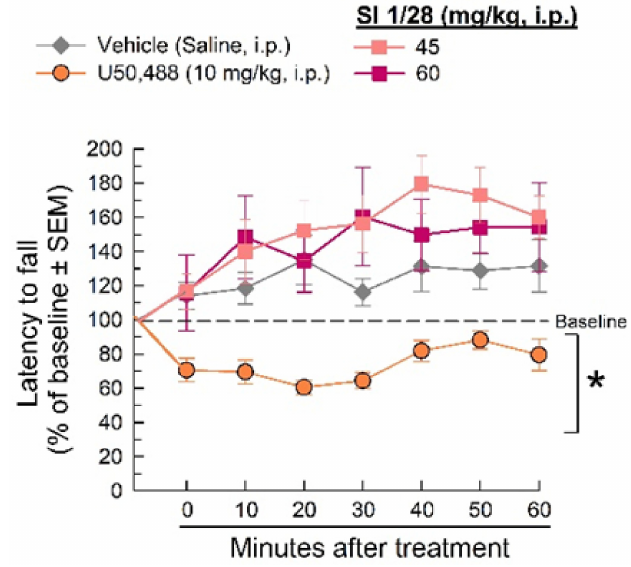
Figure 6. Dose- and time-dependent effects of SI 1/28 (squares) after 45 and 60 mg/kg i.p. adminis- tration in the mouse rotarod assay. U50,488 (10 mg/kg, i.p; orange circles.) is the positive control. * = significantly different than vehicle (0.9% saline; gray diamonds), p < 0.05; two-way ANOVA w/Dunnett’s post hoc test; n = 8–12